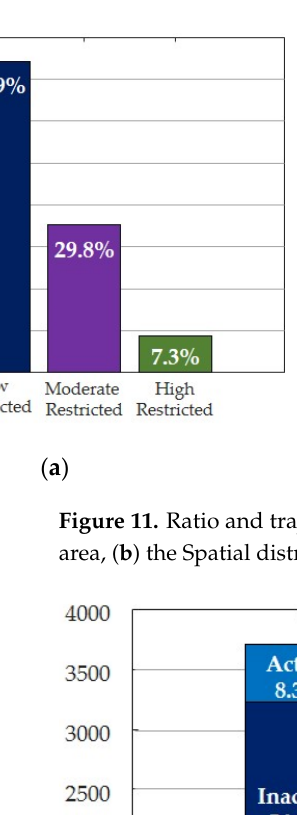
Figure 11. Ratio and trajectory distribution of the first stage clustering result: ( a ) The ratio of each area, ( b ) the Spatial distribution of each cluster.